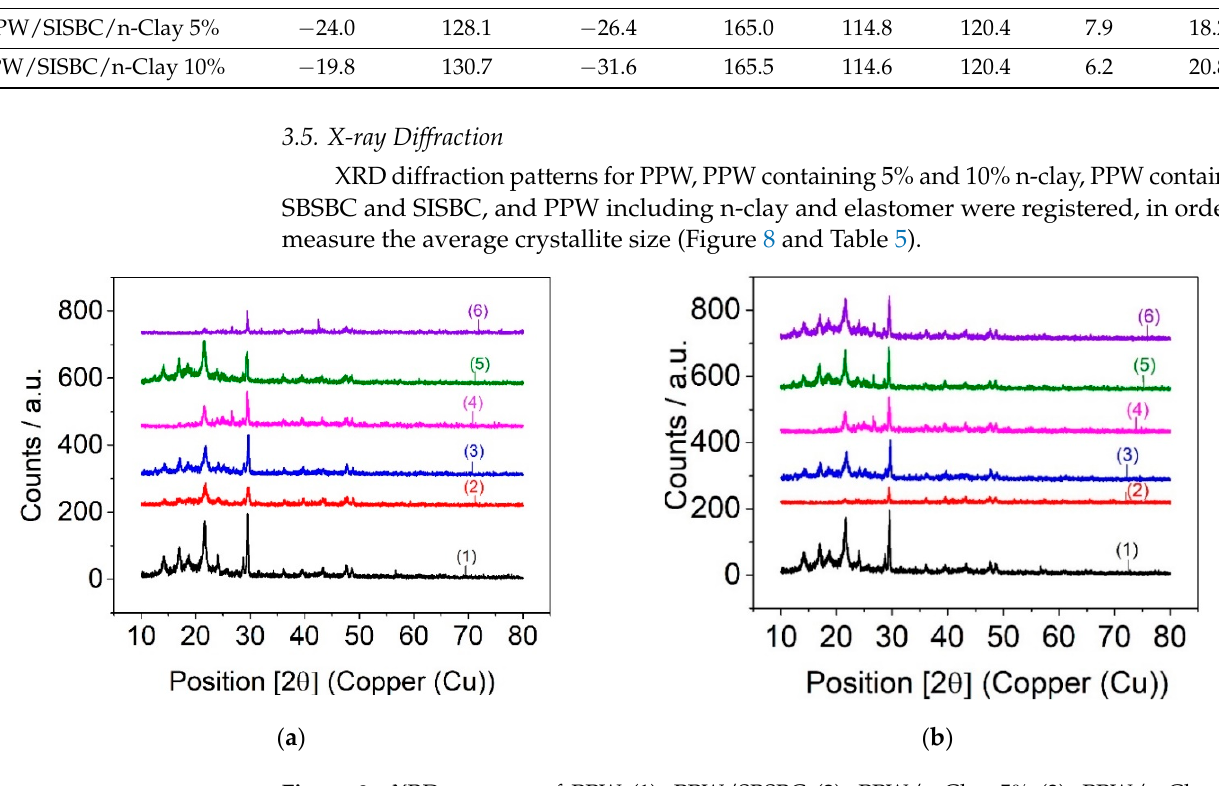
Table 5. The average crystallite size of PPW composites.